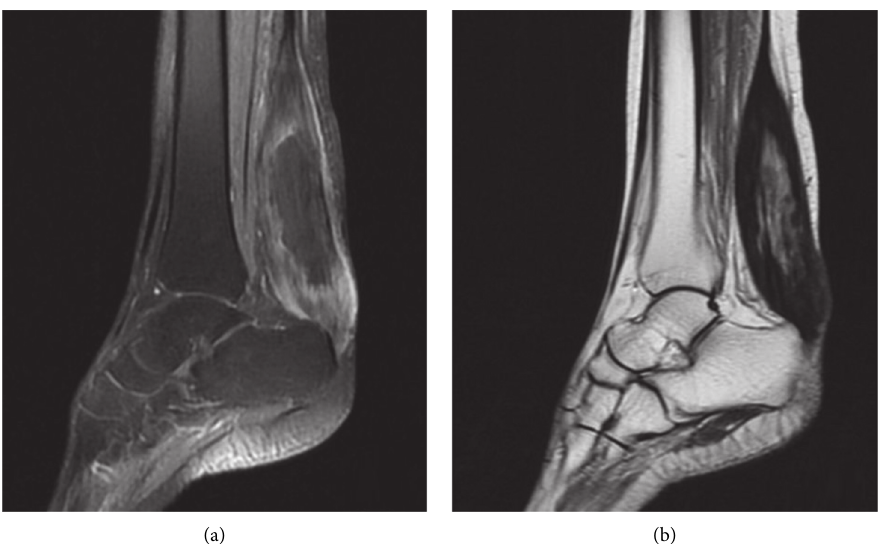
Figure 2: Sagittal images of the ankle MRI showing diffuse thickening of the Achilles tendon hypointense in T1 (a) and heterogeneous hypersignal in T2